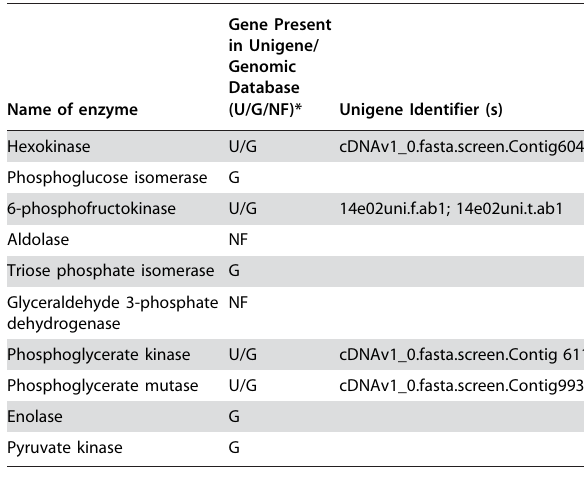
(contig961) had very high similarities to fungal citrate synthases ( CIT1 ), as well as a multitude of corresponding genomic sequences (Table 5.). Contigs 749 and 808 shared high similarities to ATP citrate lyase subunits 1 and 2 (E.C: 2.3.3.8). This 2 subunit protein is encoded by 2 genes in S. pombe , neither of which is found in S. cerevisiae. A genomic contig in the P. carinii genome database appears to encode both subunits. These subunits catalyze the